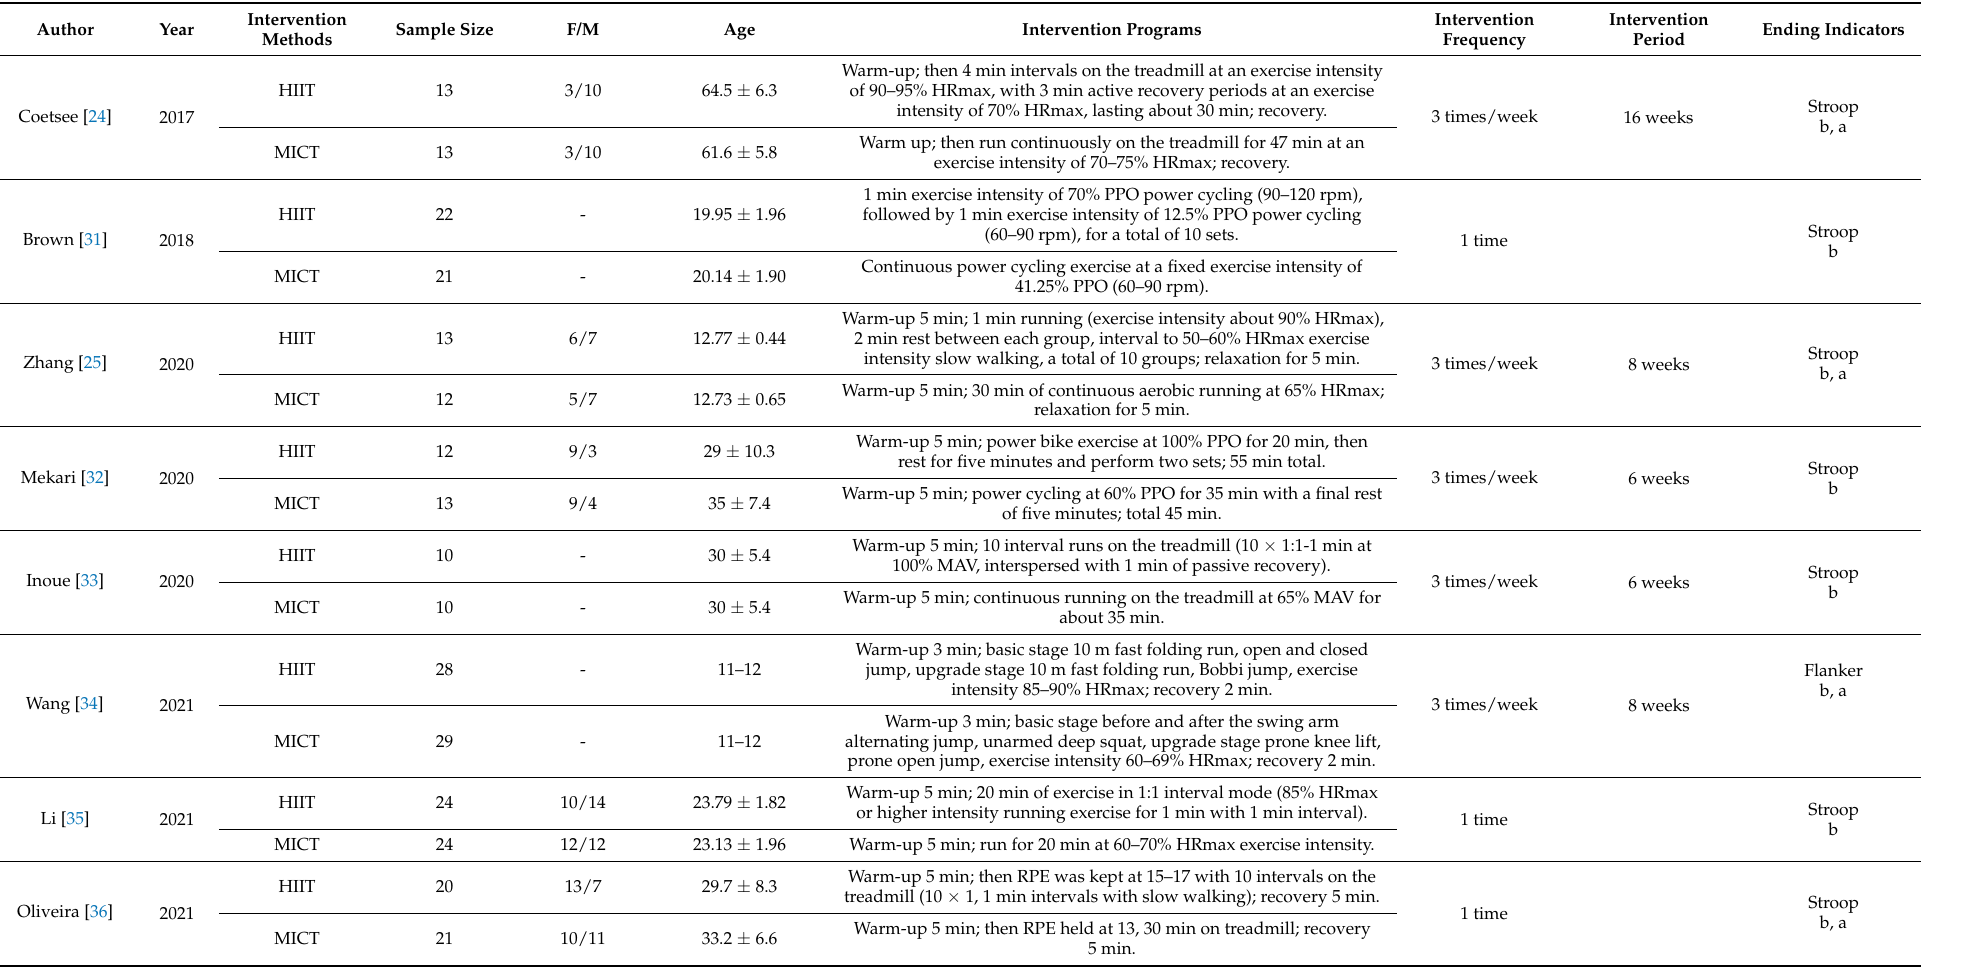
Table 2. Basic information of the included